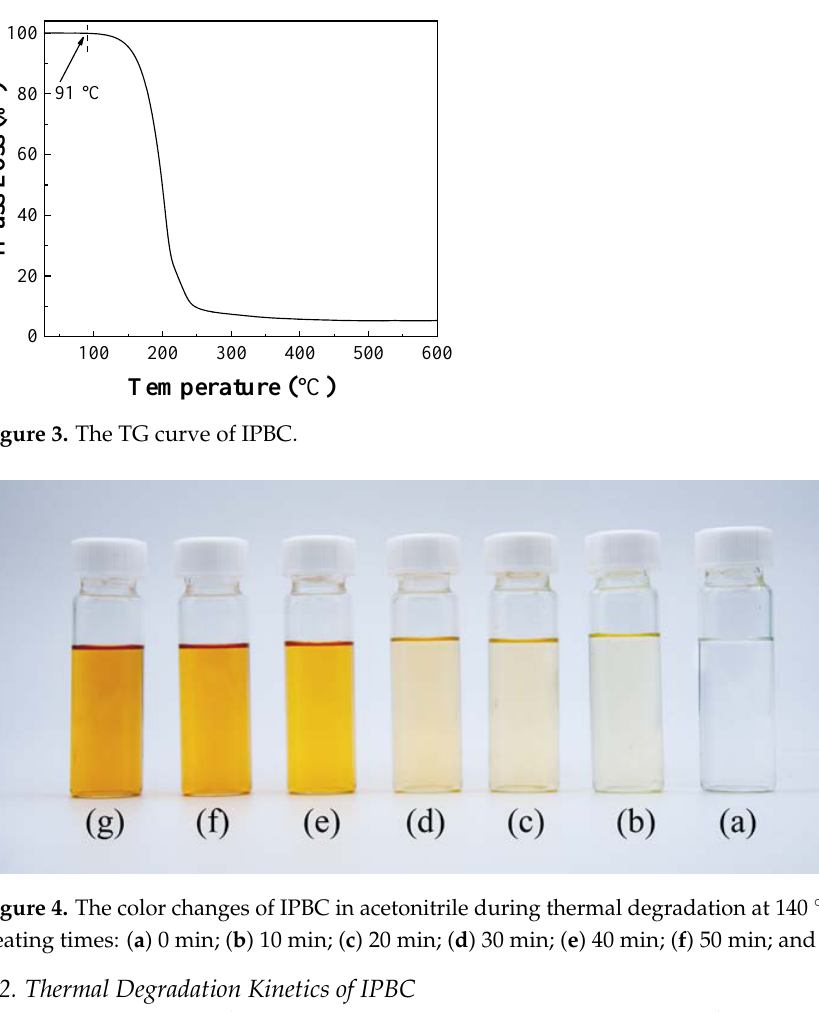
Figure 2. Thermal degradation of IPBC at different heating temperatures: ( a ) 60–100 °C; ( b ) 110–150 °C. Each point represents the average of three replicas per thermal treatment. Figure 3. The TG curve of IPBC.